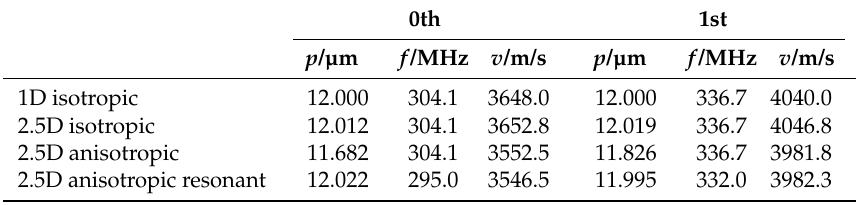
Table 1. Comparison of results from 1D and 2.5D model with isotropic parameters, 2.5D model with anisotropic parameters for p = 12µm and h GL = 18µm for the 0th and 1st order mode.